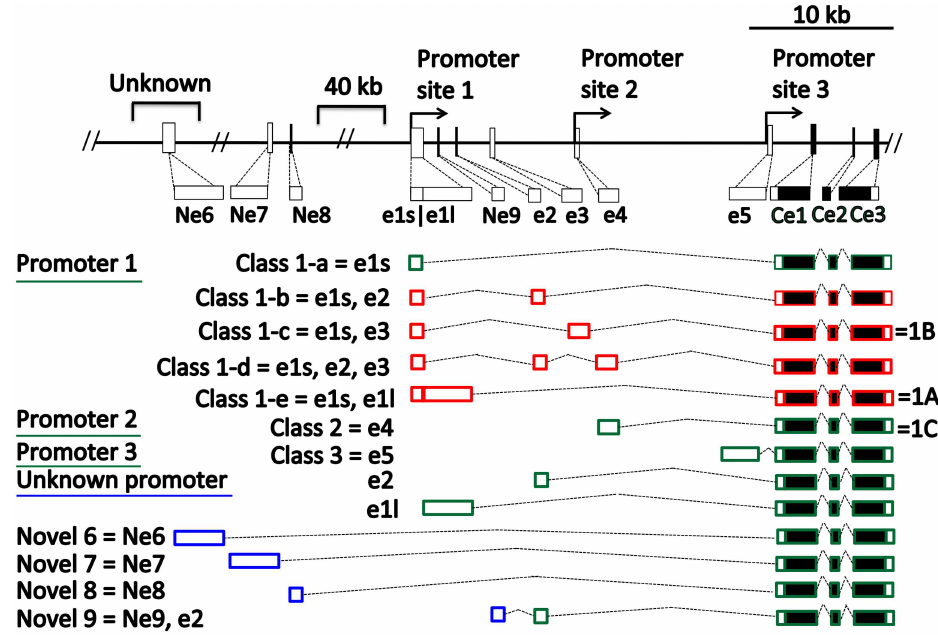
Fig 2. Correspondence of ASIP alternatively spliced transcripts between embryonic Japanese quail, adult quail and chicken. Empty boxes represent non-codingexons and solid boxes denote coding exons (Ce1-3). Green lines and green boxes represent promoter sites and transcripts, respectively, that were successfully amplifiedin quail embryonic development, whereasred denotestranscripts that were not amplified. Previouslyreportedchicken transcript names beginwith “Class” and the exons which they are comprisedof beginwith “e” and are listed in the middle[4]. Previously reportedadult quail transcripts begin with “1” and are denotedto the right of the correspondingchicken transcript after the codingexons [4,21]. The names of the novel ASIP transcripts uncovered in this study begin with “Novel” and the exons they are comprisedof are represented with blue boxes. The promoter site of the novel transcripts is